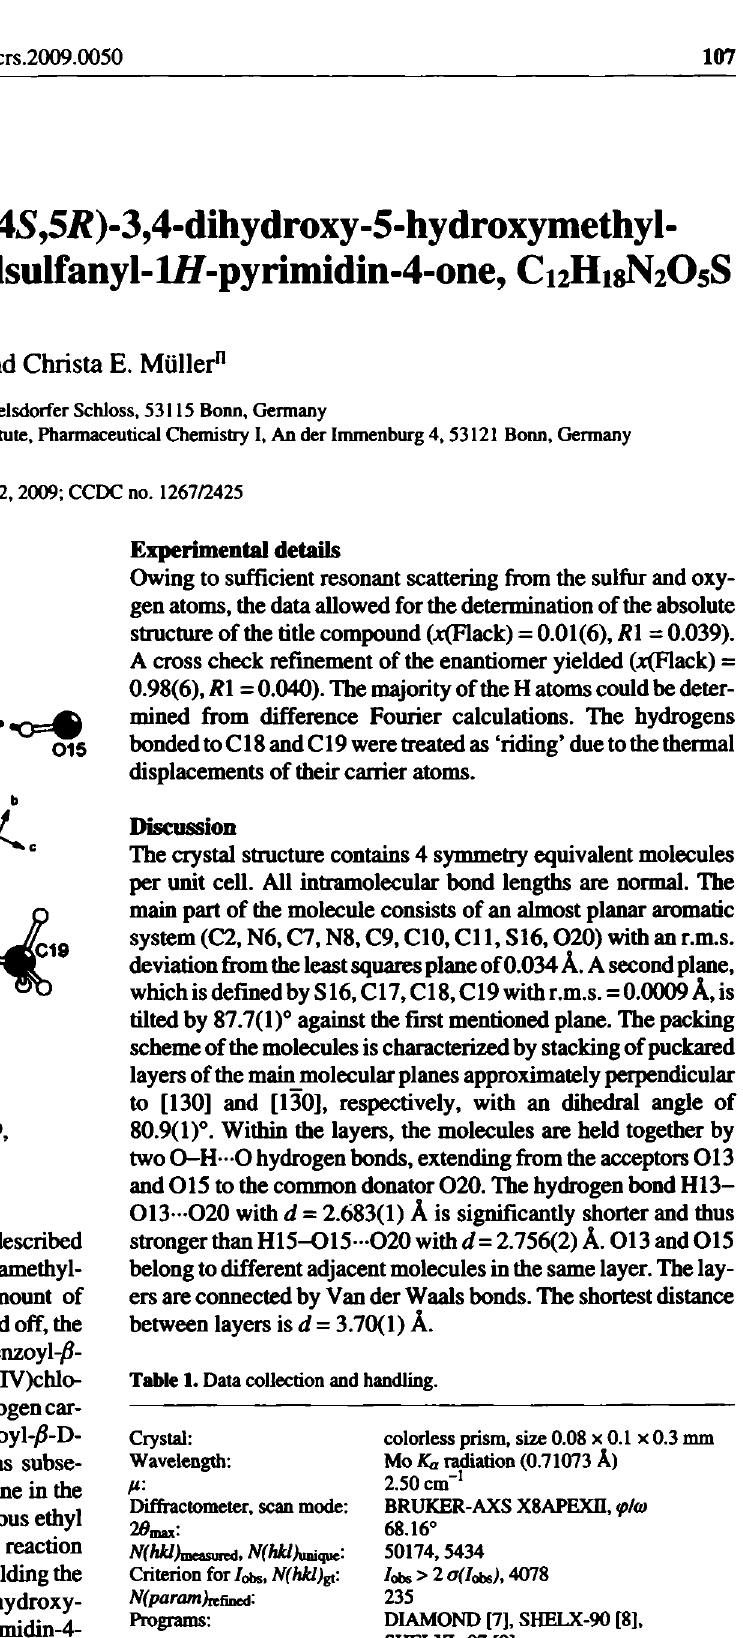
Table 2. Atomic coordinates and displacement parameters (in Â 2